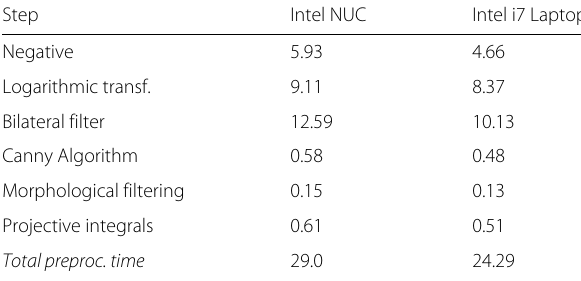
Table 7 Processing average time for each step of the preprocessing and the total